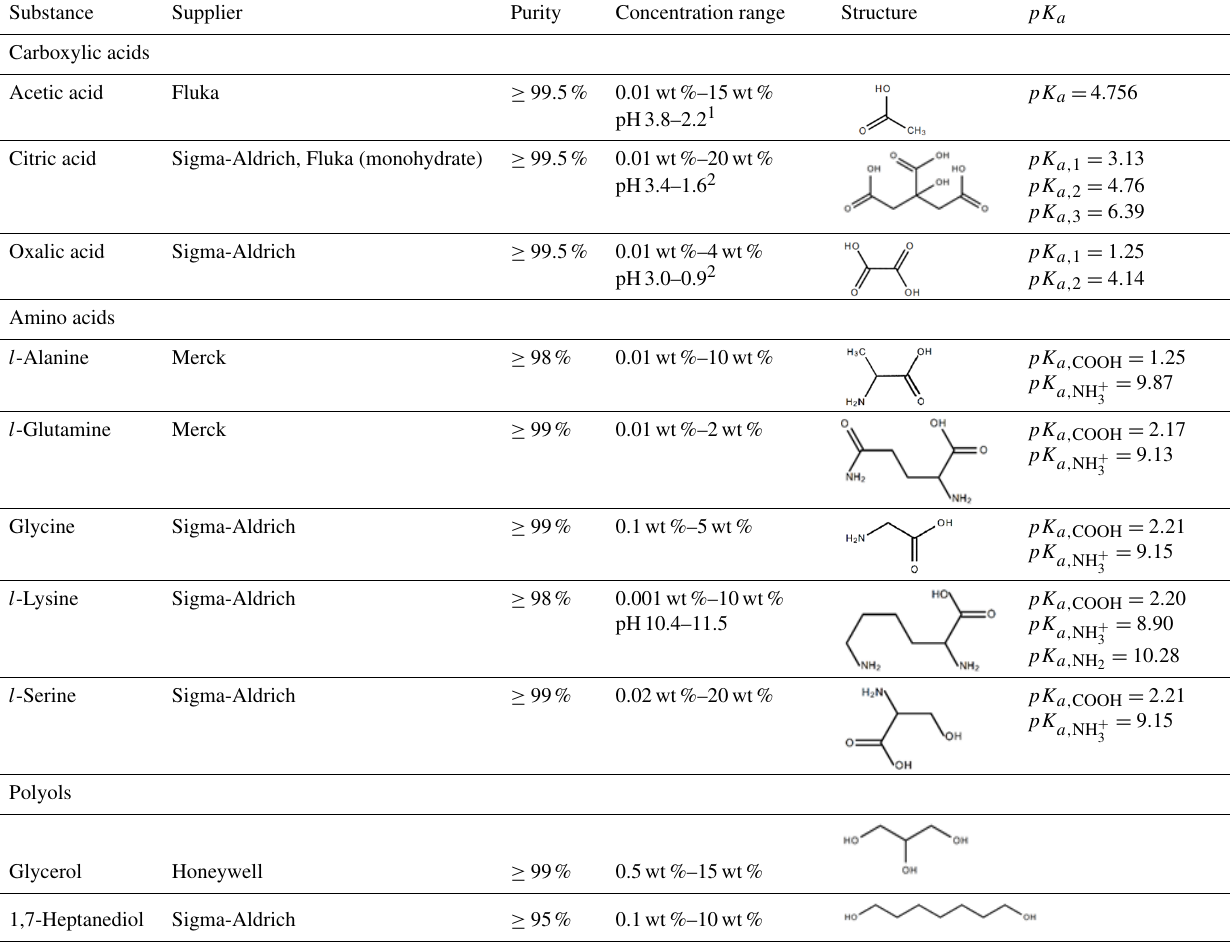
Table 1. Summary of all solutes used. Stated are the supplier of the substance, the purity, and the concentration range used in the experiments. Substance Supplier Purity Concentration range pK